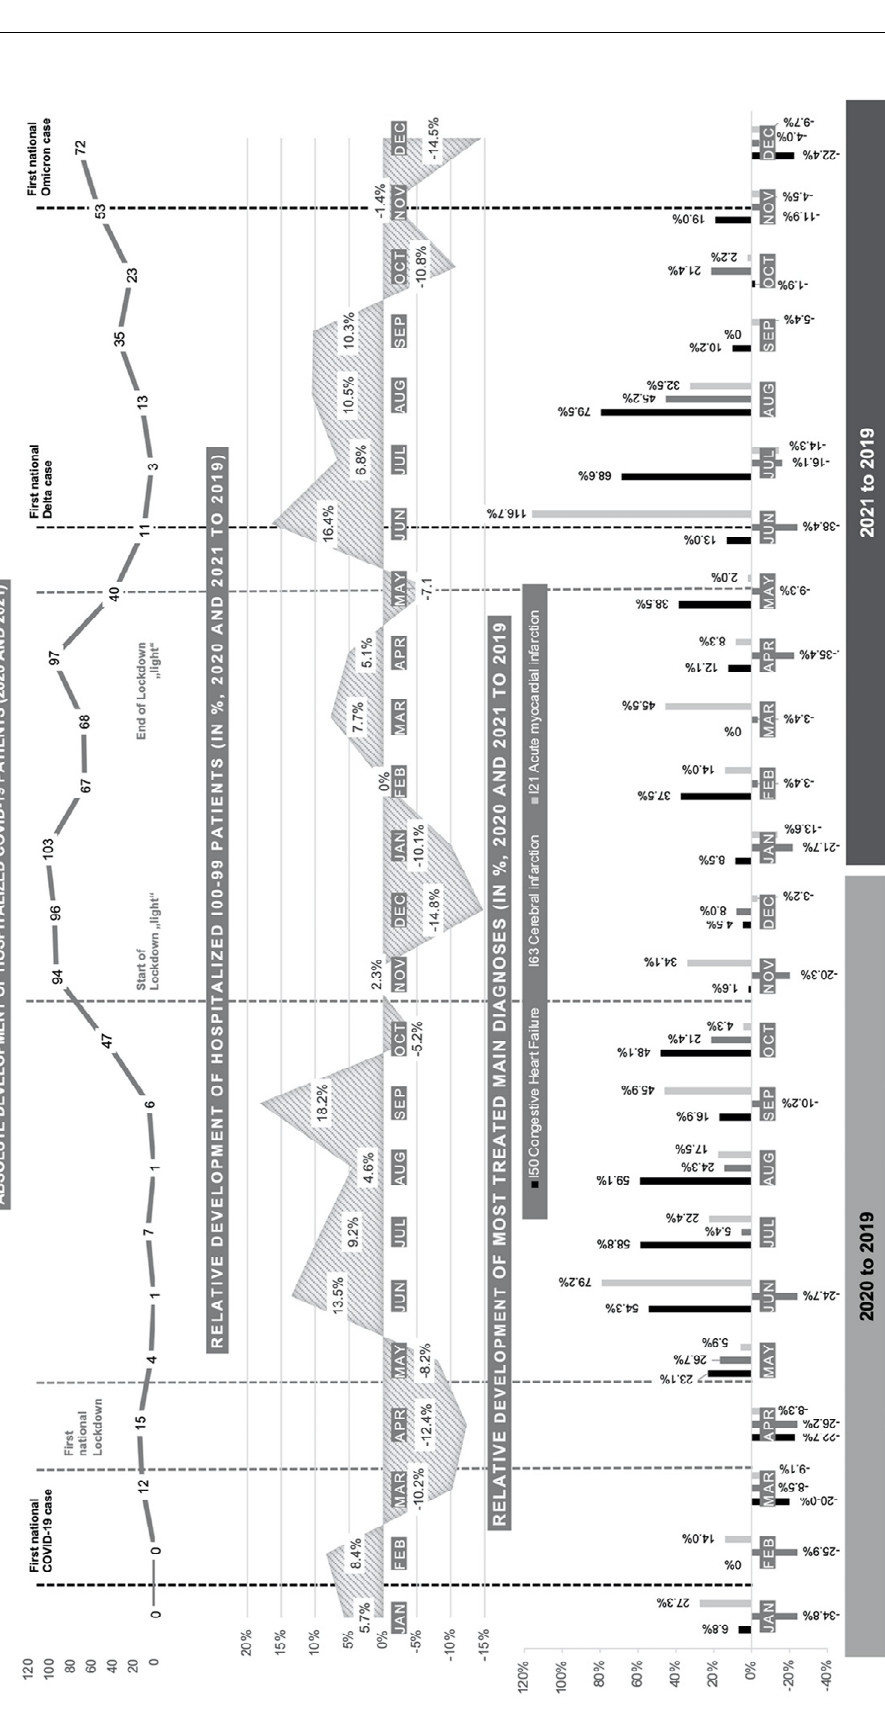
Figure 1. Monthly relative development of hospitalized cardiovascular and COVID-19 patients (2019–2021).